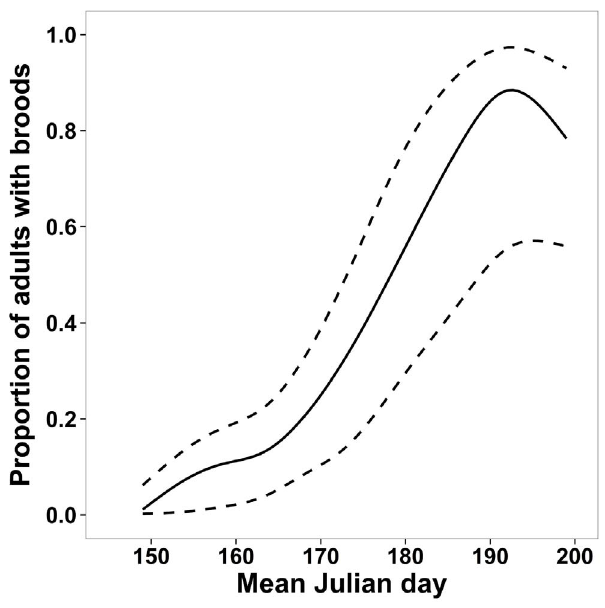
Figure 2. Estimated parental status at pair level. Model averaged estimated parental status ( Y pair ) at pair level as a function of mean Julian day (first observation Julian day: 28 May = day 148) at Foreˆt Montmorency (Que´bec, Canada). Dashed lines delimit the 95% confidence interval.